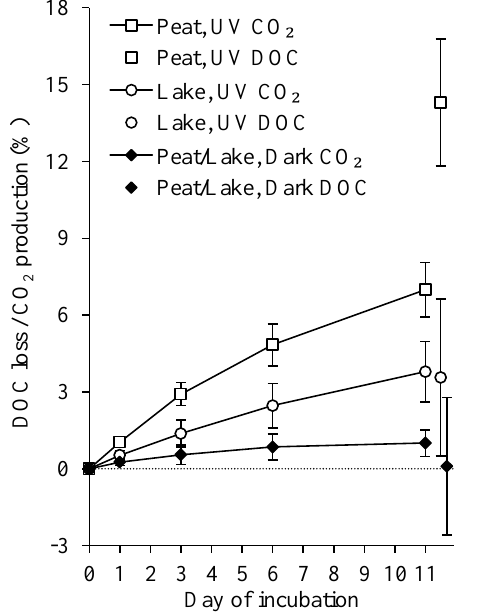
Fig. 9. Production of CO 2 during dark and UV incubations of lake DOC samples, reported as a fraction of the initial DOC pool, com- pared to measurements of DOC loss, comparing initial and end of incubation DOC concentrations. Error bars indicate ± 1 standard de- viation, n = 30. Results from mineral well incubations not included since CO 2 production estimates were affected by calcium carbonate